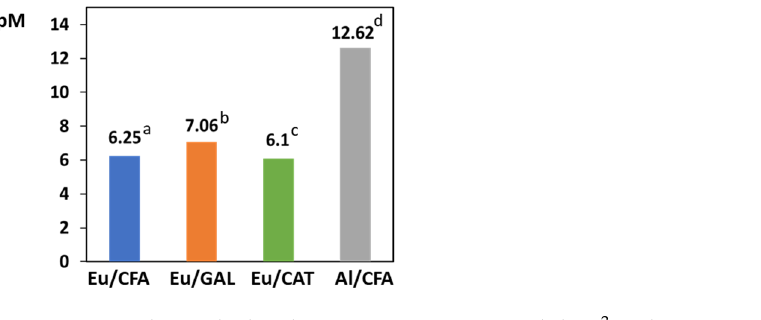
Figure 9. pM values calculated at pH = 7.4, c M = 1 µ mol · dm − 3 and c L = 10 µ mol · dm − 3 , for several M/polyphenolic systems (M = Eu 3+ , Al 3+ ), using data (a) determined in this work; reported in (b) [62]; (c) [63]; (d) [59].